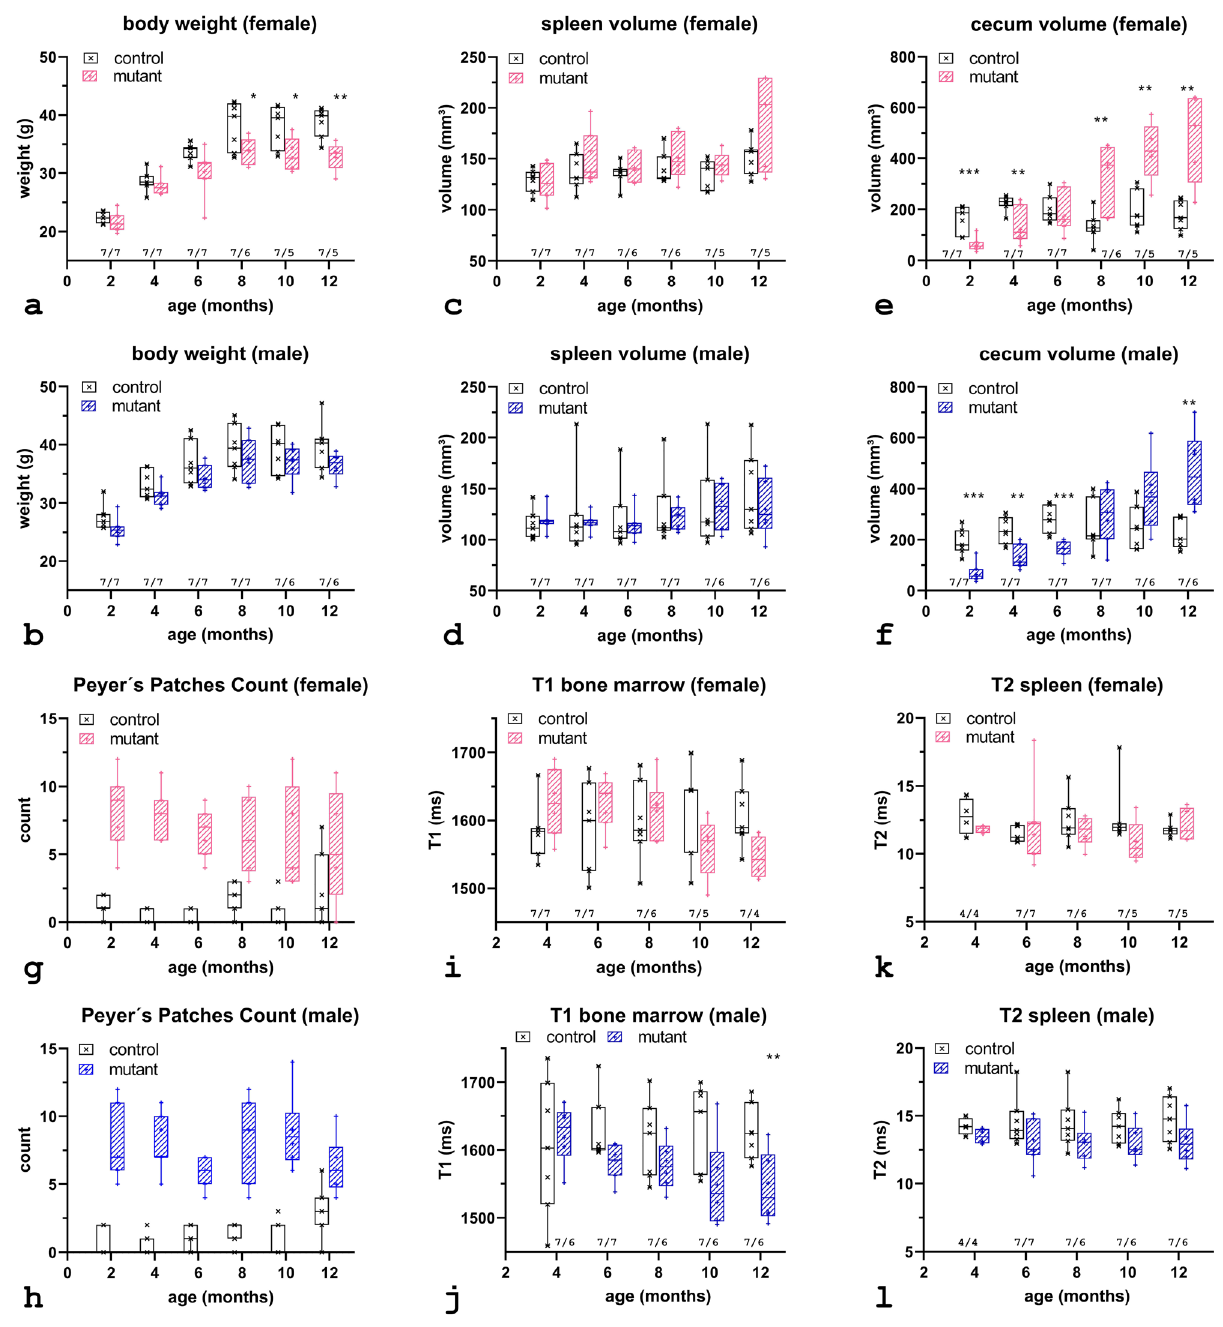
Figure 1. Body weight ( a , b ) significantly reduced weight was observed for the mutant females ( a ) initially detectable at the age of 8 months. Splenic volume ( c , d ) no genotype dependent difference was noticed; a sex- specific difference was detected at four and eight months. At the third measurement point data of one female bearing splenic cancer was excluded. Cecal volume ( e , f ) a temporal varying phenotype was observed for the cecal volume in mutants. The progression correlated with the form of the cecum, the initial decreased volume turned into a significant increase at later age. Peyer’s Patches ( g , h ) analysis of the MR images revealed prominent Peyer’s patches located inside the cecum. Manual enumeration revealed that, on average, up to five times more nodules were present in the mutants. T1 relaxometry ( i , j ) revealed possible changes in the cell composition of the hematopoietic tissue of the mutants with increasing age. Compared with controls, a trend toward T1 shortening was observed. T2 relaxometry ( k, l ) no genotype dependent difference was observed. However, T2 times were significantly longer in males, indicating a higher iron load in females. Markers representing individual data samples, bar indication median value; animal numbers are given below the box plots; *, p ≤ 0.05; **, p ≤